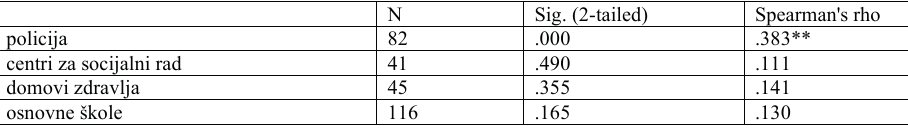
**Correlation is significant at the 0.01 level